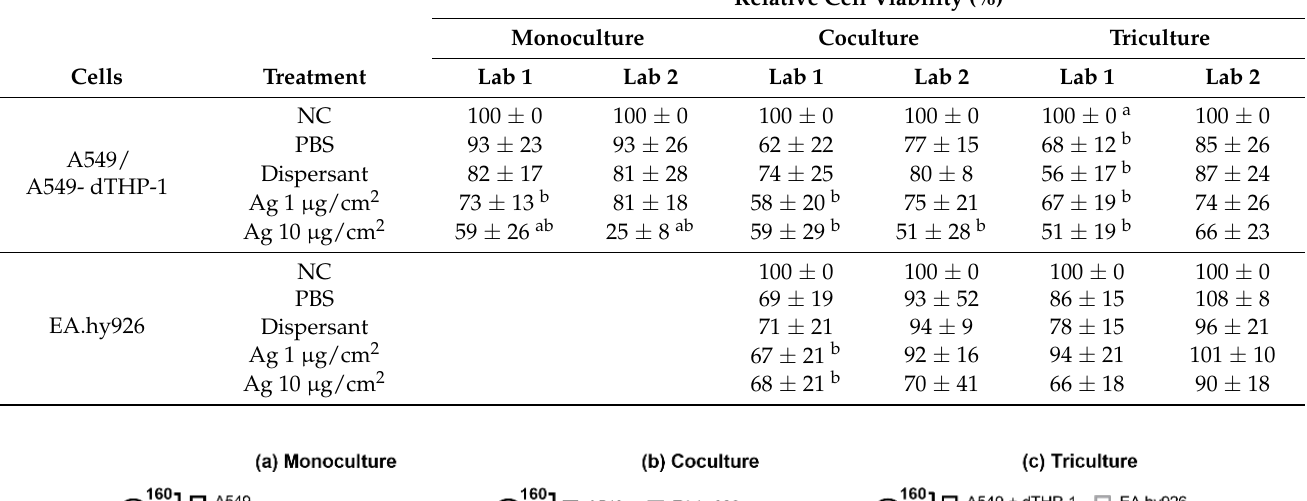
Table 2. Cell viability (%) relative to incubator control (set to 100%) measured by the AlamarBlue assay after exposure of monocultures, cocultures, and tricultures of A549, EA.hy926, and dTHP-1 cells to NM-300K (1 and 10 µ g/cm 2 ) or control solutions (PBS, dispersant (NM-300K DIS)) at the air–liquid interface (ALI). Results are presented as mean with standard deviation from a total of n = 6–9 (Lab 1), n = 3 (Lab 2) for monocultures, for cocultures n = 4–5 (Lab 1), n = 3 (Lab 2), and for tricultures n = 4 independent experiments with each 1–2 replica cell culture inserts, corresponding to results in Figure 5. Statistically significant differences compared to PBS or NC incubator controls were analyzed by one-way ANOVA with multiple comparisons post-test Dunnett’s and are indicated by a p < 0.5 compared to PBS, and b p < 0.05 compared to NC. NC: negative control, PBS: phosphate buffered saline, dTHP-1: differentiated THP-1 cells.